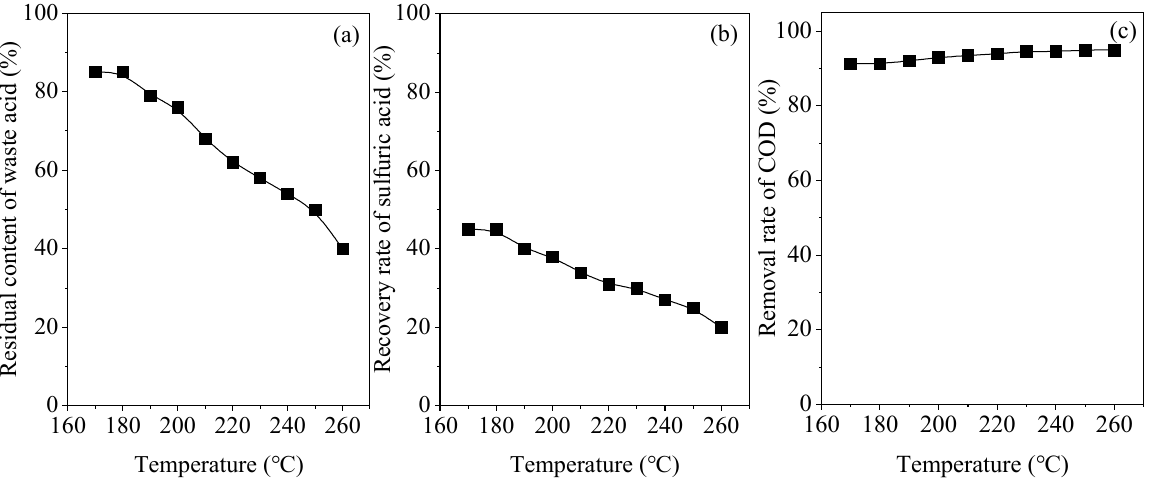
Figure 2. Effect of temperature on ( a ) residual content of waste acid, ( b ) recovery rate of sulfuric acid, and ( c ) removal rate of COD.